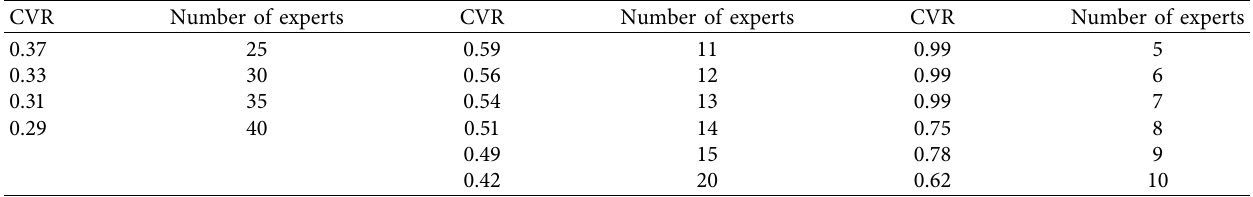
Table 2: Minimum acceptable CVR value for content validity.